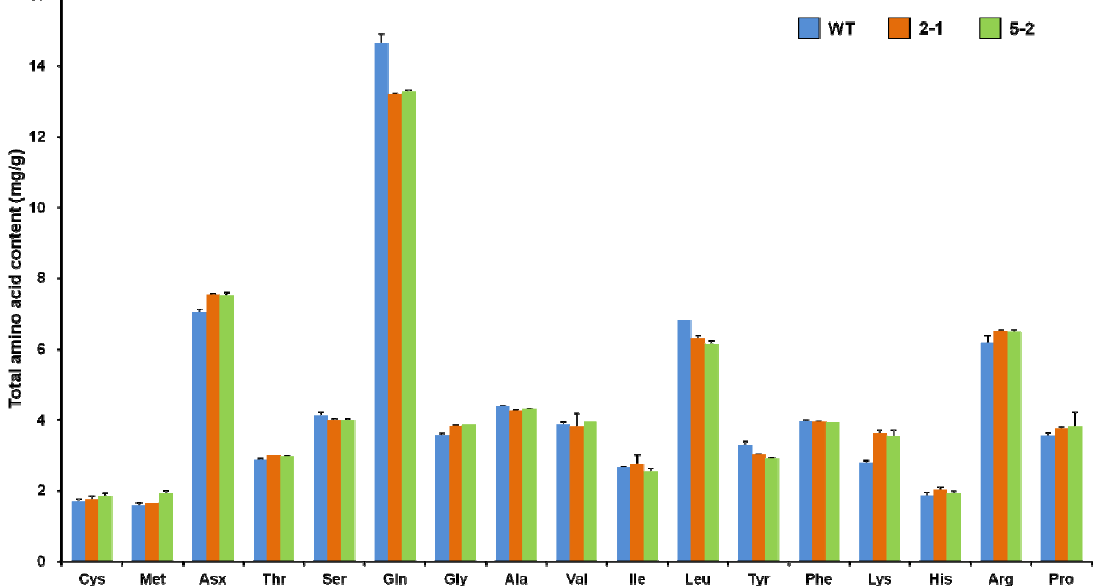
Figure 3. Amino acid composition in mature grains of the wild type (WT) and 13 kD pro-RNAi lines (2-1 and 5-2, respectively). Values are means ± SD (error bars) of two